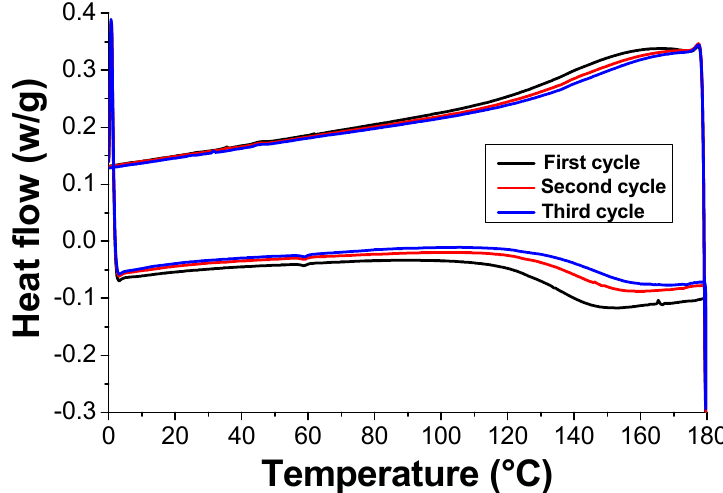
Figure 6. DSC thermogram of the cross-linked nanocomposite containing the 5.5 wt% of rGO. Notably, as seen in Figure 7 as the temperature increased by more than 10 °C with the filler content, the energy substantially diminished by about 1.25 J/g, thus indicating that rGO affected the thermal stability of the crosslinked system. This effect was already observed in PKFU networks doped with MWCNTs although apparently smaller than that reported here for rGO [15].